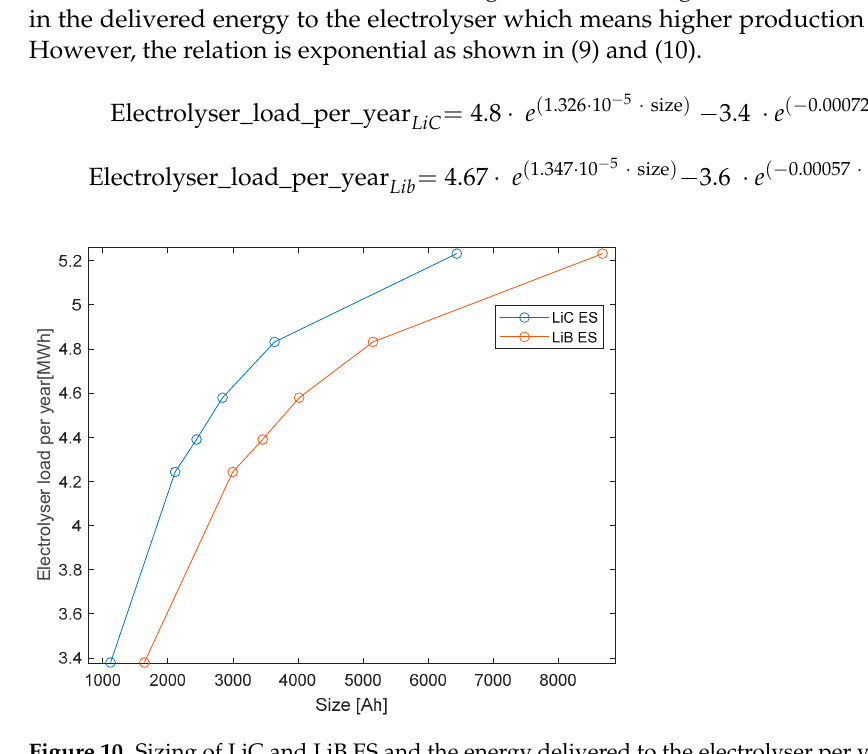
As it can be seen from Table 2 and Figure 10, increasing the size of the ES is reflected in the delivered energy to the electrolyser which means higher production of hydrogen. However, the relation is exponential as shown in (9) and (10).